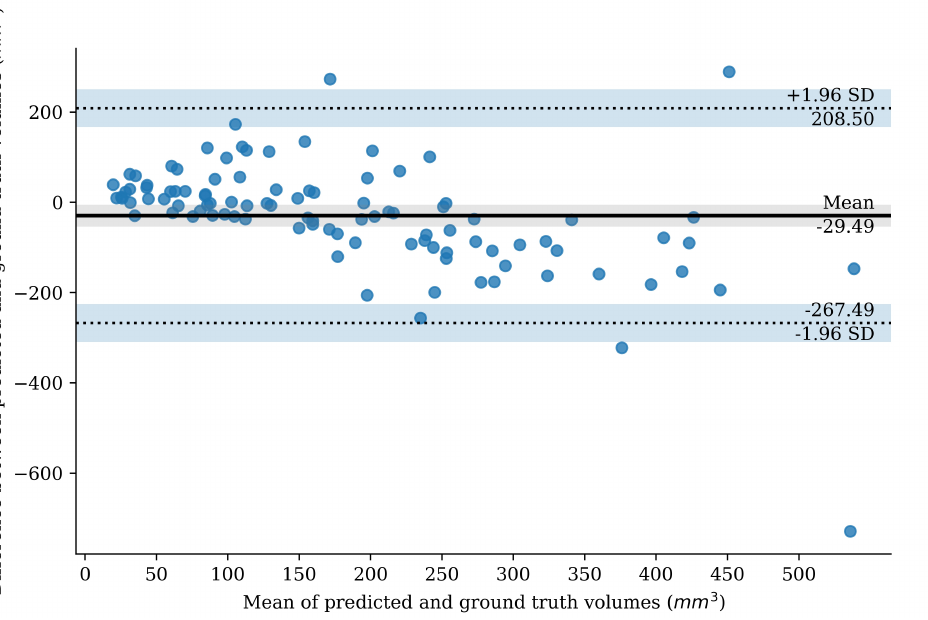
Figure 6. Bland–Altman plot for thrombus volume based on weighted-sum predictions. The mean volume difference is shown as a horizontal line. The 95% of the differences between the ground truth and the predictions fall within the limits of agreement that is also depicted on the